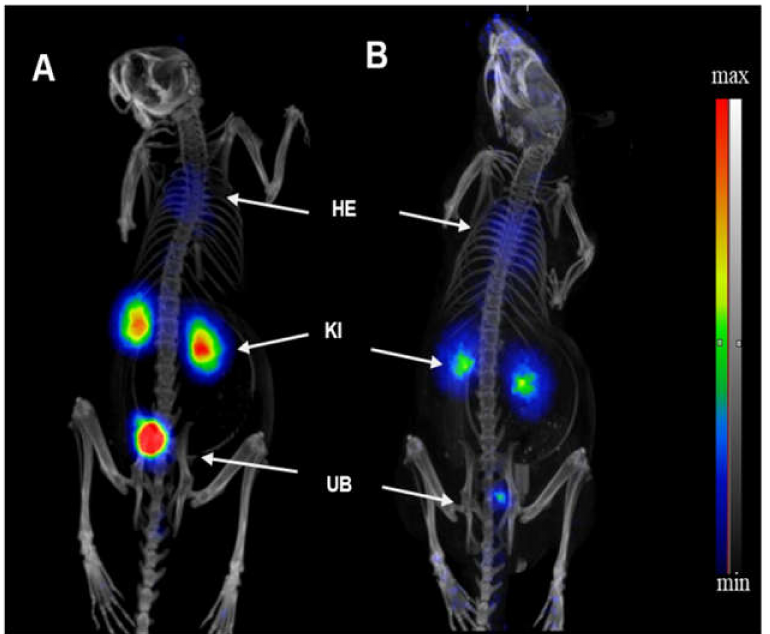
Figure 1. Representative maximum intensity projection microPET/CT images: Healthy BALB/c mice received a 0.1 mL intravenous injection of [ 68 Ga]Ga-PSMA-617-ME via the lateral tail vein. PET/CT image acquisition data from ( A ) up to 40 min post injection was reconstructed and displayed and compared to ( B ) [ 68 Ga]Ga-PSMA-617-ME PET/CT at 90–120 min. Recognized 68 Ga-activity is visible in the myocardium (HE), both kidneys (KI), and the urinary bladder